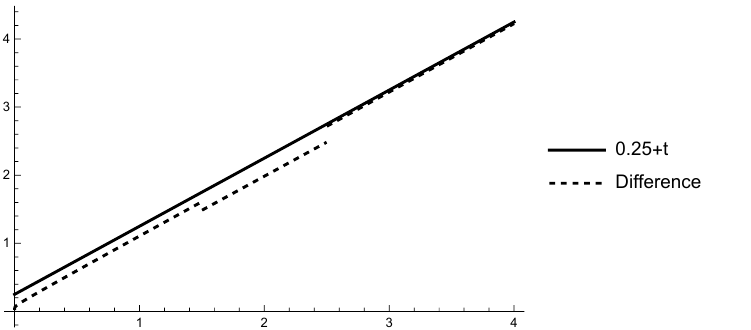
Figure 1. Graph of the bound 0.25 + t and the difference of the function v ( t ) = t and its integral presentation on [ 0,4 ]